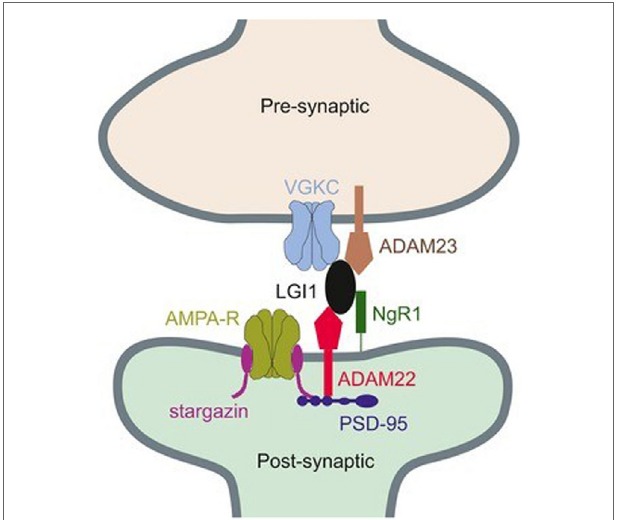
FiGURe 1 | Connection between presynaptic voltage-gated potassium channel (vGKC) complex and postsynaptic AMPAR through a ternary complex, formed by ADAM22, leucine-rich glioma inactivated 1 (LGi1), and ADAM23 (55) . Copyright 2017 and Copyright 2015, Wiley’s Open Access Terms and